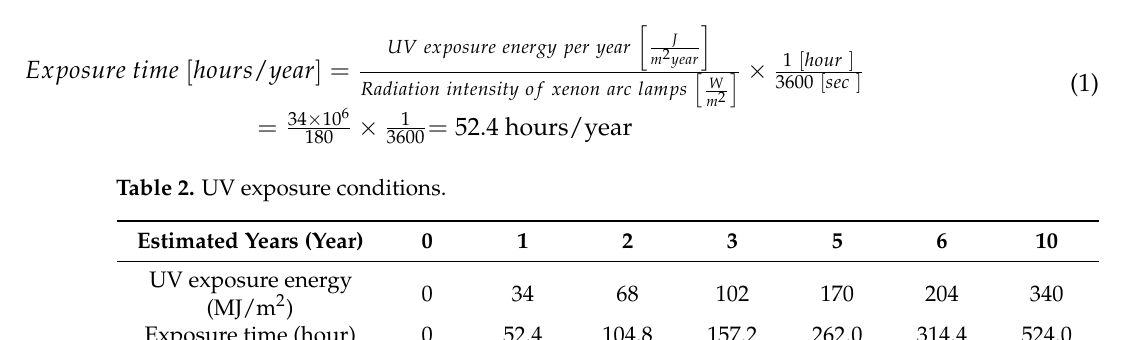
Figure 3. Example of sample holders’ placement in the xenon-arc weathering meter. The letters “A”, “B”, and “C” represent the xenon arc lamp, the black panel thermometer, and the test frame with two test specimens, respectively.